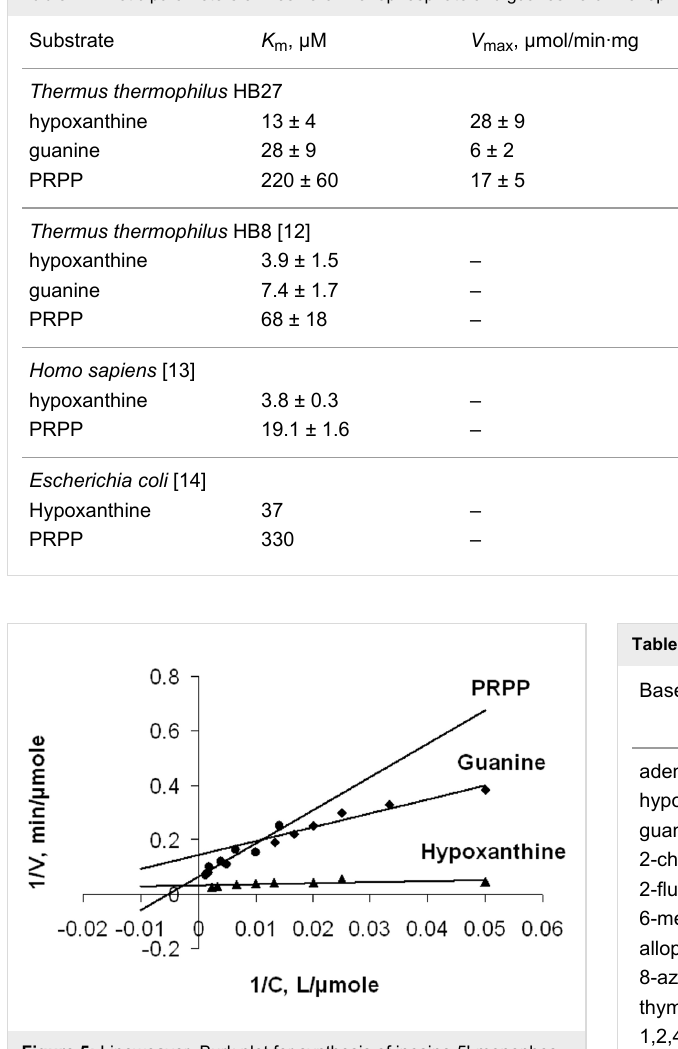
Figure 5: Lineweaver–Burk plot for synthesis of inosine-5'-monophos- phate and guanosine-5'-monophosphate.